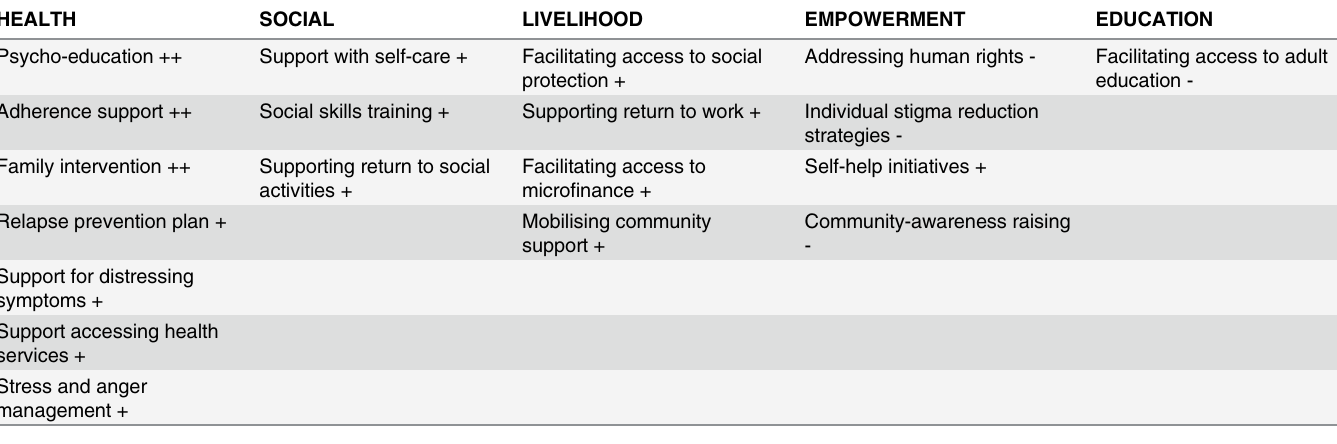
Table 3. Potential components of community-based rehabilitation for